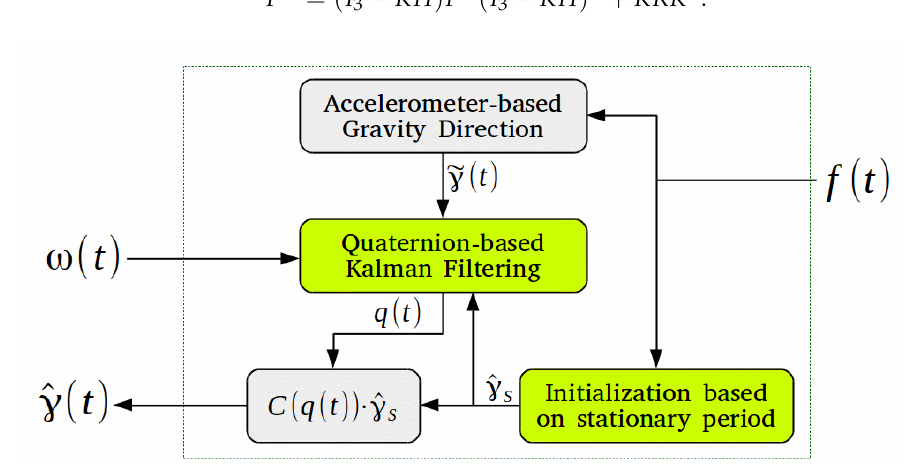
Figure 1. Structure of the filter for gravity direction estimation. Input signals from the accelerometer and gyroscope are f ( t ) and ω ( t ) , respectively, while the output ˆ γ ( t ) is the estimated gravity unit